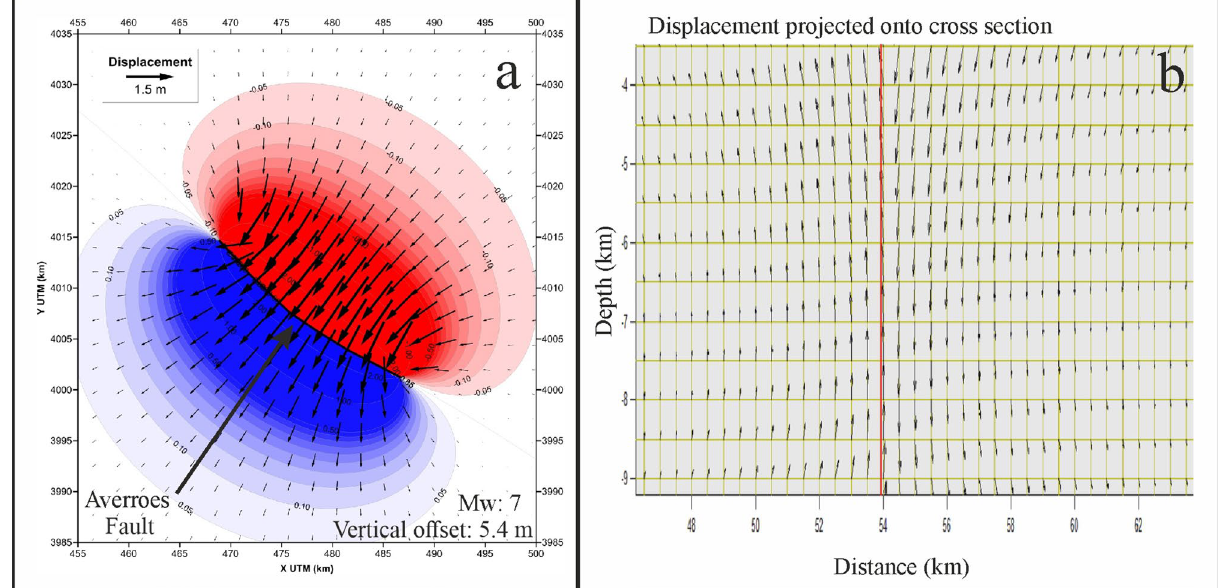
Figure 3. Seafloor deformation. Computed deformation pattern of the crust affected by the Averroes Fault for a vertical offset of 5.4 m and an associated magnitude of Mw 7. ( a ) Seafloor plan view: red indicates downthrow and blue indicates uplift; ( b ) Vertical section: red line represents the Averroes Fault trace. (Figures generated with Coulomb, v. 3.3, USGS, https:// www. usgs. gov/ softw are/ coulo mb-3 and Surfer, v. 12.0.626, Golden Software, https:// www. golde nsoft ware. com and mounted with CorelDRAW v. X7, https:// www. corel.